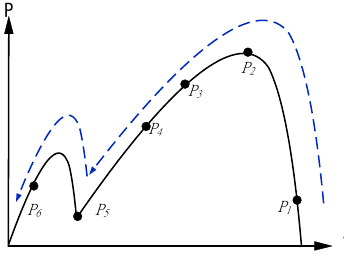
Figure 6. The P-V curve with the proposed GMPS method.